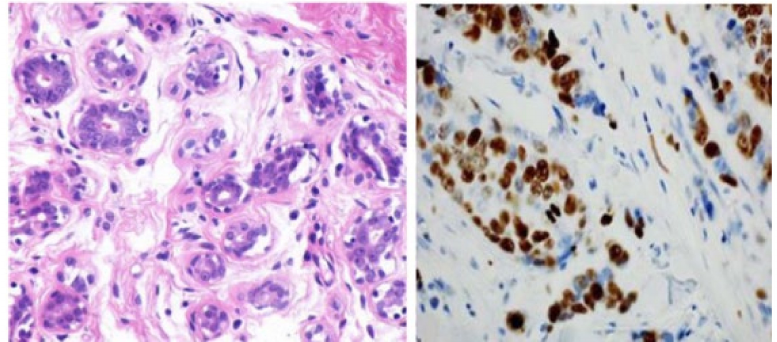
Figure 5. Images of the breast from H&E (haemotoxylin and eosin) stained image of a benign case provided by histopathology imaging modality [105]. Reprinted/adapted with permission from [105]. 2017, Elsevier.